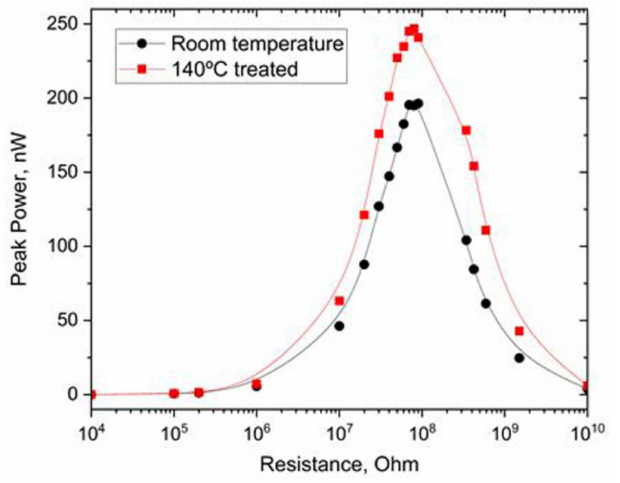
Figure 7. Comparison of the peak power measurements of FF-based TENGs prepared at room temperature and heated to 140 ◦